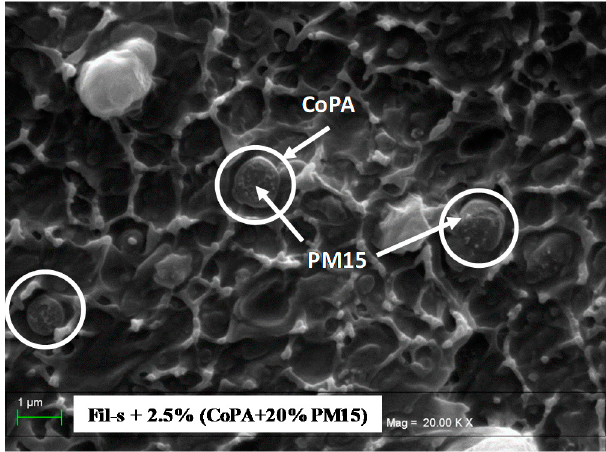
Figure 7. SEM image of the blend Fil-s + 2.5%(CoPA + 20%PM15). The copolyamide phase is evidenced inside the white circular lines.